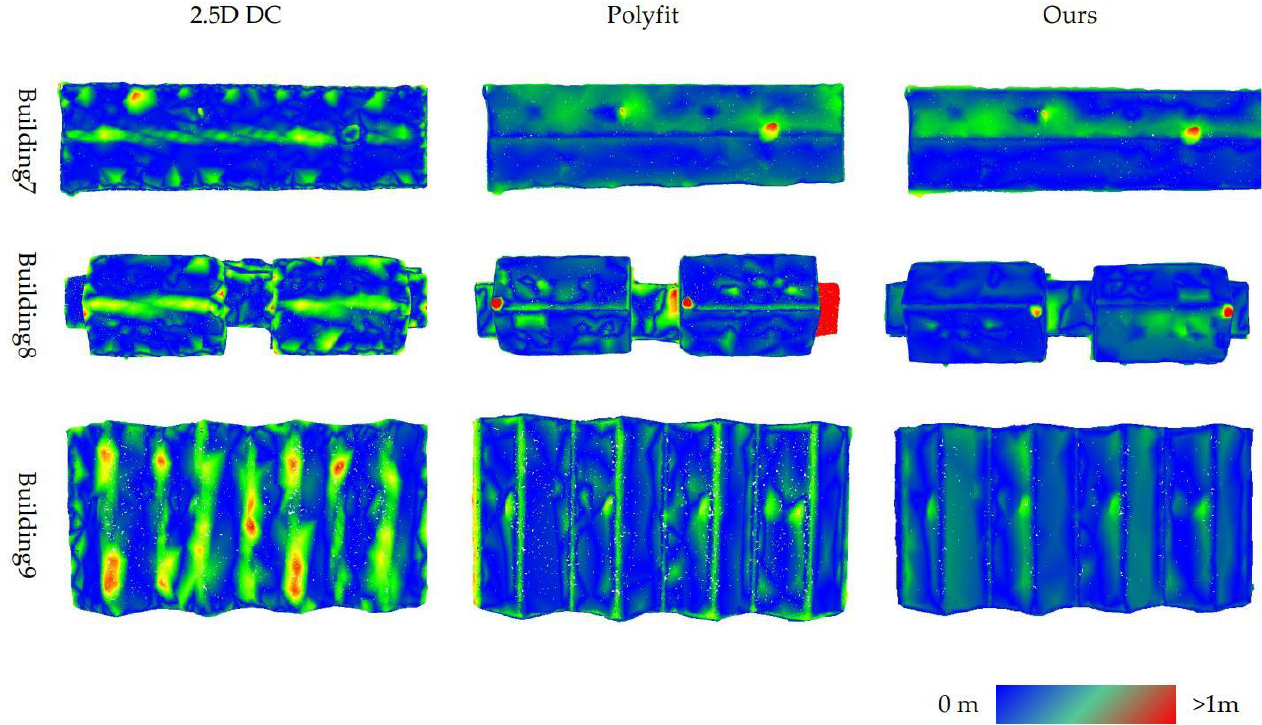
Figure 16. Evaluations of reconstructed Buildings 7 – 9 using the 2.5D DC, PolyFit, and the proposed method. The distance of the point cloud to the model is rendered with color.